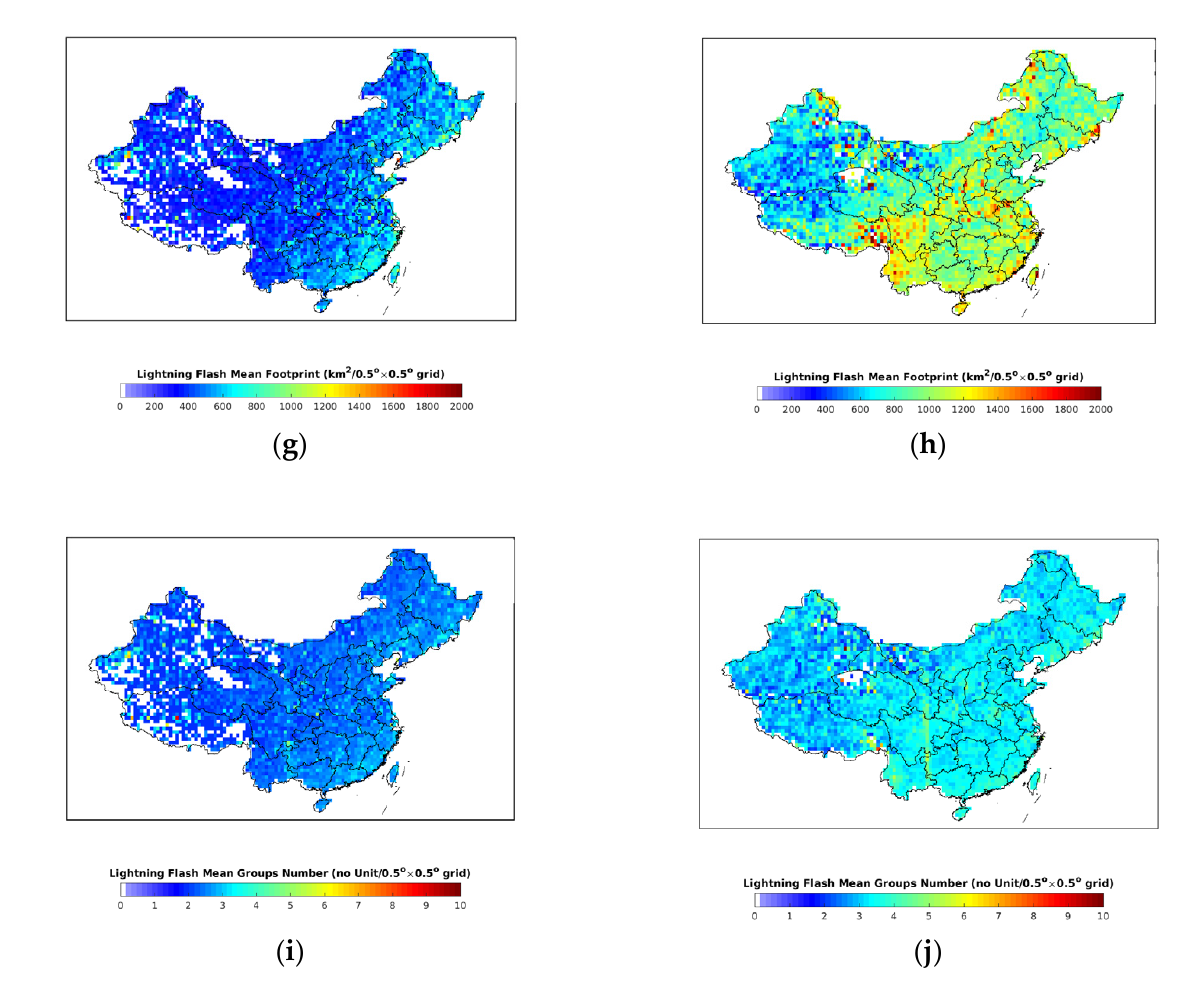
Figure 6. Spatial distribution features of LMI Flash during daytime and nighttime. ( a , b ) LMI Flash density, ( c , d ) Radiance, ( e , f ) Duration, ( g , h ) Footprint, and ( i , j ) Flash-Group number. Four regions are compared: (1) TibetanPlateau (26–35°N, 78–100°E); (2) Beijing-Tianjin-Hebei region (36–42°N, 113–119°E); (3) Yangtze River Delta region (26–35°N, 117–122°E); and (4) Pearl River Delta region (21–28°N, 113–11° o E).Figures (a,c,e,g,i) show the LMI Flash during daytime, while figures (b,d,f,h,j) show the LMI Flash during nighttime.